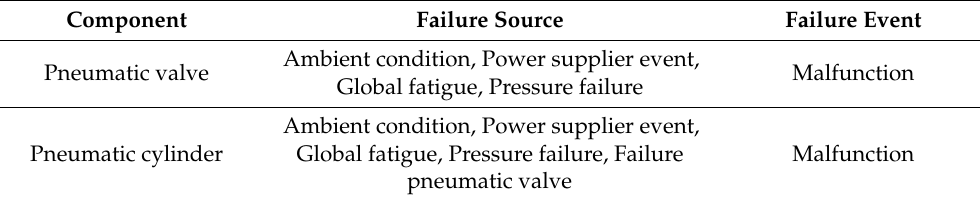
Table 4. Pneumatic components in the studied MSTM with failure source and